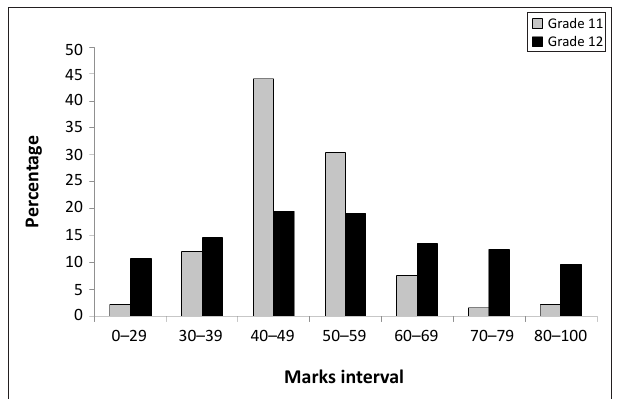
FIGURE 2: Distribution of Grade 11 and Grade 12 mathematics marks.